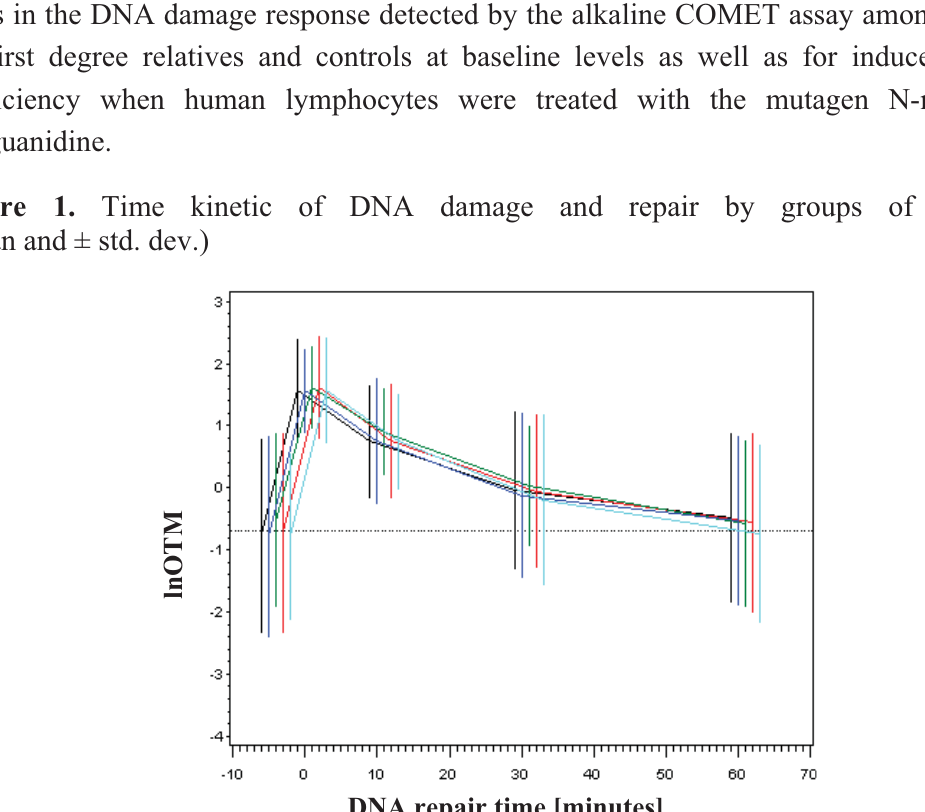
DNA repair time [minutes] From the left to the right: parents (black), siblings (dark blue), partners (green), index persons (cases; red), offspring (light